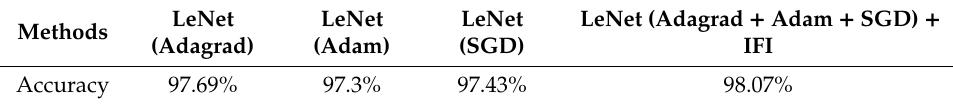
Table 12. Recognition results of LeNet architectures with di ff erent optimization